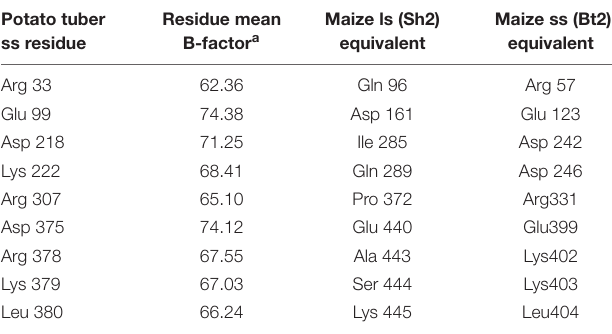
TABLE 1 | Maize endosperm AGPase residues predicted to have unusually high relative B-factors by analogy with the potato small subunit homotetramer x-ray crystal structure (Jin et al.,